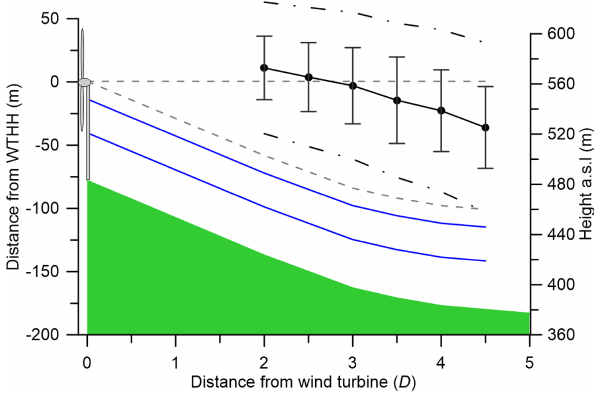
Figure 14. The mean height of the wake centre is shown with a solid black line ( ± 1 standard deviation in solid grey lines) for distances downwind of the wind turbine at 0.5 D intervals from 2 to 4.5 D for A types only. The width of the wake indicated by Eq. (11) is shown as the black dashed–dotted lines. The terrain is shown in green. The grey dashed lines indicate the expected wake centre if it remained at the WTHH and if the centre purely follows the terrain. The solid blue lines indicate the range of heights for the inner layer l from Table 1.